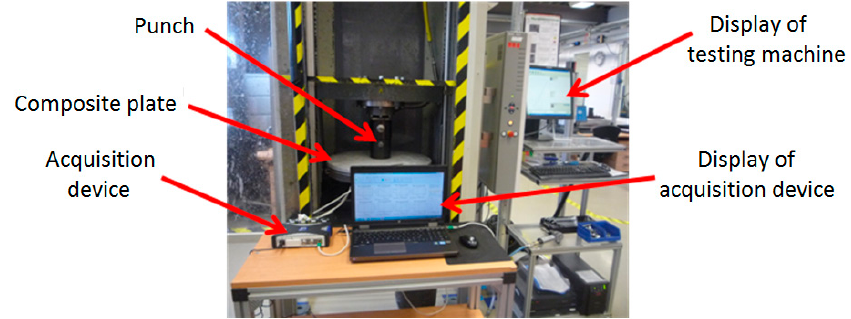
Figure 6. Photo of the experimental setup used to measure the strains developed in the composite manhole cover.